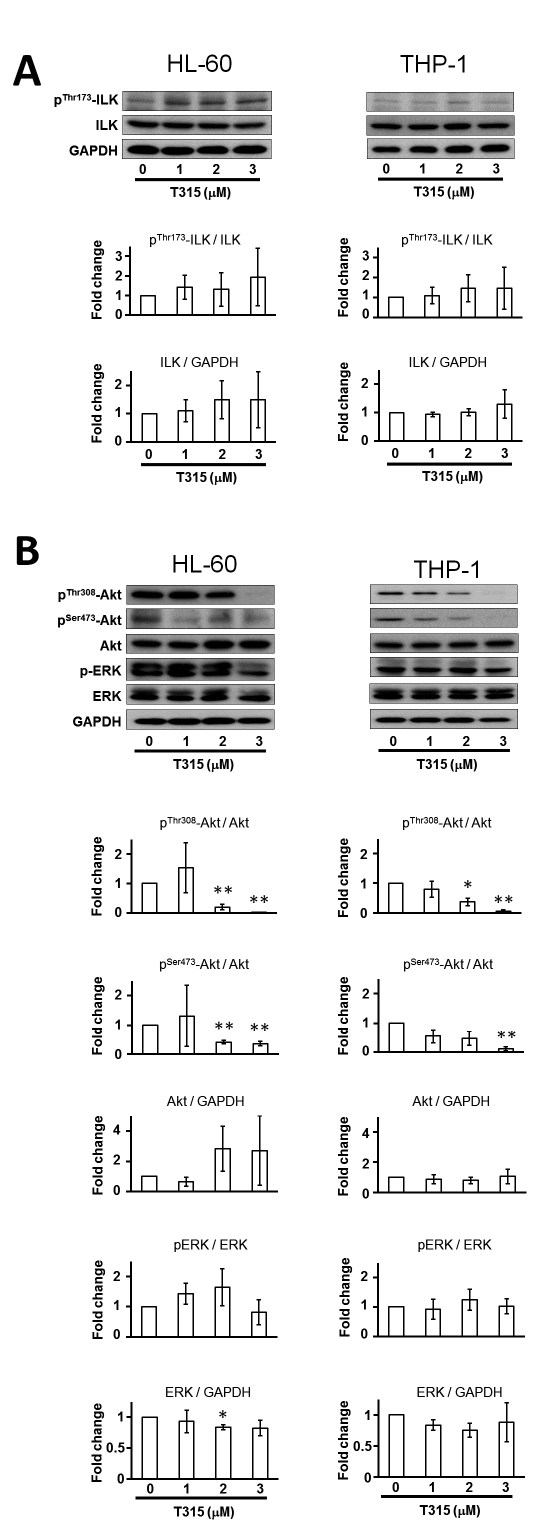
Figure 2. T315 induces dephosphorylation of protein kinase B (Akt) without change of integrin-linked kinase (ILK) in AML cell lines. Cells (0.25 × 10 6 cells/mL) were treated with T315 at the indicated concentration or DMSO for 24 h, and 20 µg protein extract from cell lysates in each condition were used for Western blot analysis. ( A ) T315 did not change the p Thr173 -ILK and total ILK expression. Histogram of fold change of p Thr173 -ILK/ILK and ILK/glyceraldehyde 3-phosphate dehydrogenase (GAPDH) were shown in lower panels ( n = 3); ( B ) T315 down regulated both p Thr308 -Akt and p Ser473 -Akt, but not Akt, p-ERK and ERK expression. Histogram of fold change of p Thr308 -Akt/Akt, p Ser473 -Akt/Akt, Akt/GAPDH, p-ERK/ERK, and ERK/GAPDH were shown in lower panels ( n = 3). * denotes p < 0.05; ** denotes p < 0.01 compared to the control group.